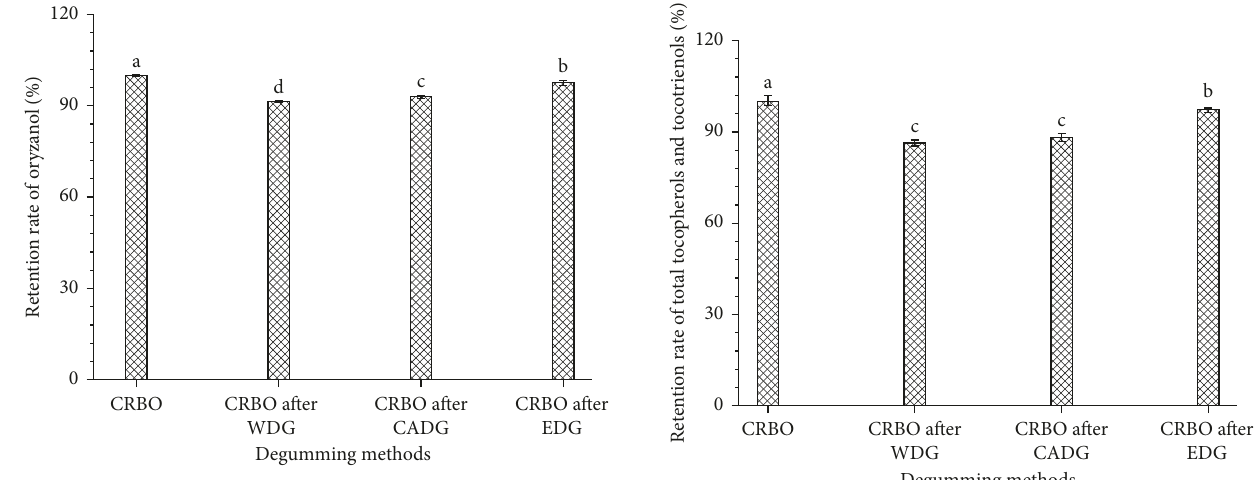
Figure 3: Effect of degumming methods on retention rate of oryzanol. Note: lowercase superscripts represent significant dif- ferences between different methods ( P